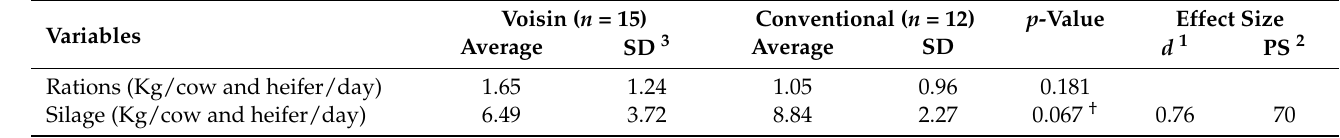
Table 4. Average rations and silage used per cow and heifer per day.